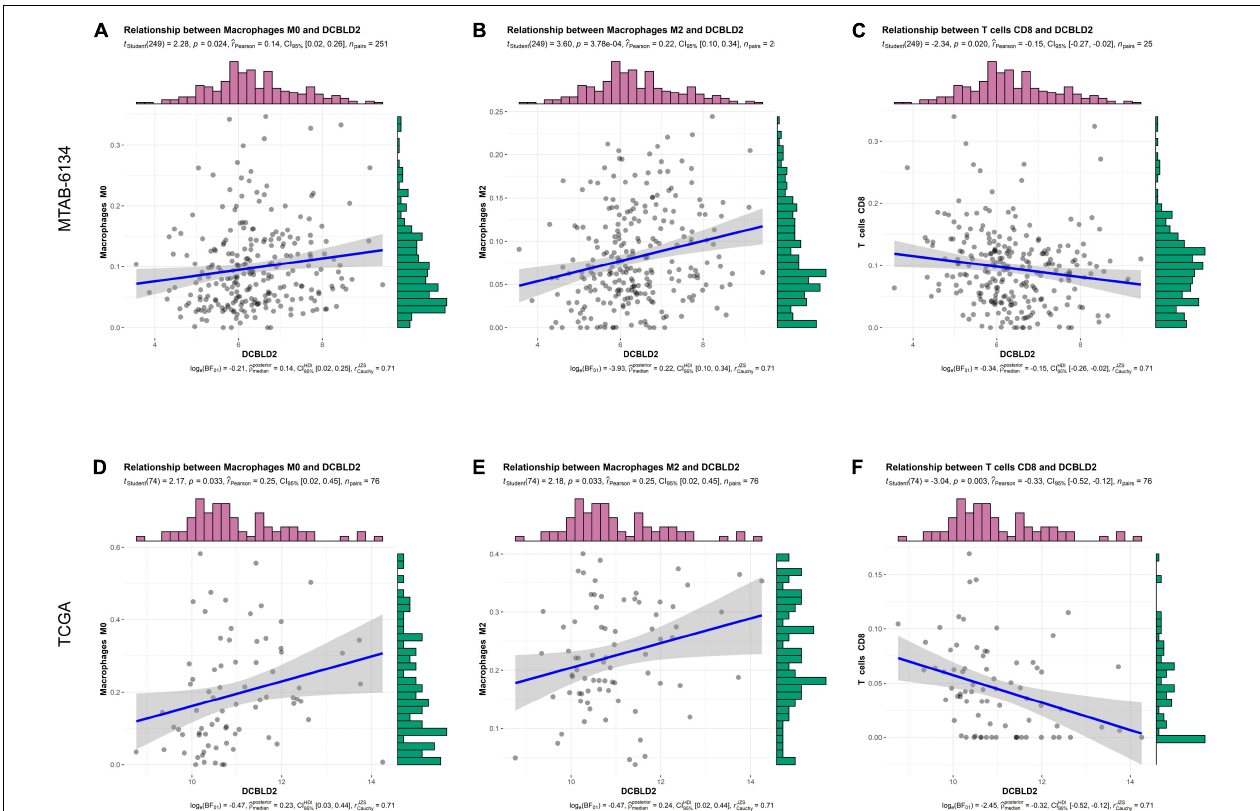
FIGURE 6 | Correlation analysis between DCBLD2 expression and immune infiltrates. (A–C) The correlation between DCBLD2 expression and the abundance of macrophage M0, macrophage M2, and CD8 + T cell in MTAB-6134 cohort, respectively. (D–F) The correlation between DCBLD2 expression and the infiltration of macrophage M0, macrophage M2 and CD8 + T cell in TCGA cohort, respectively. The correlation coefficients and p value were derived from Pearson correlation